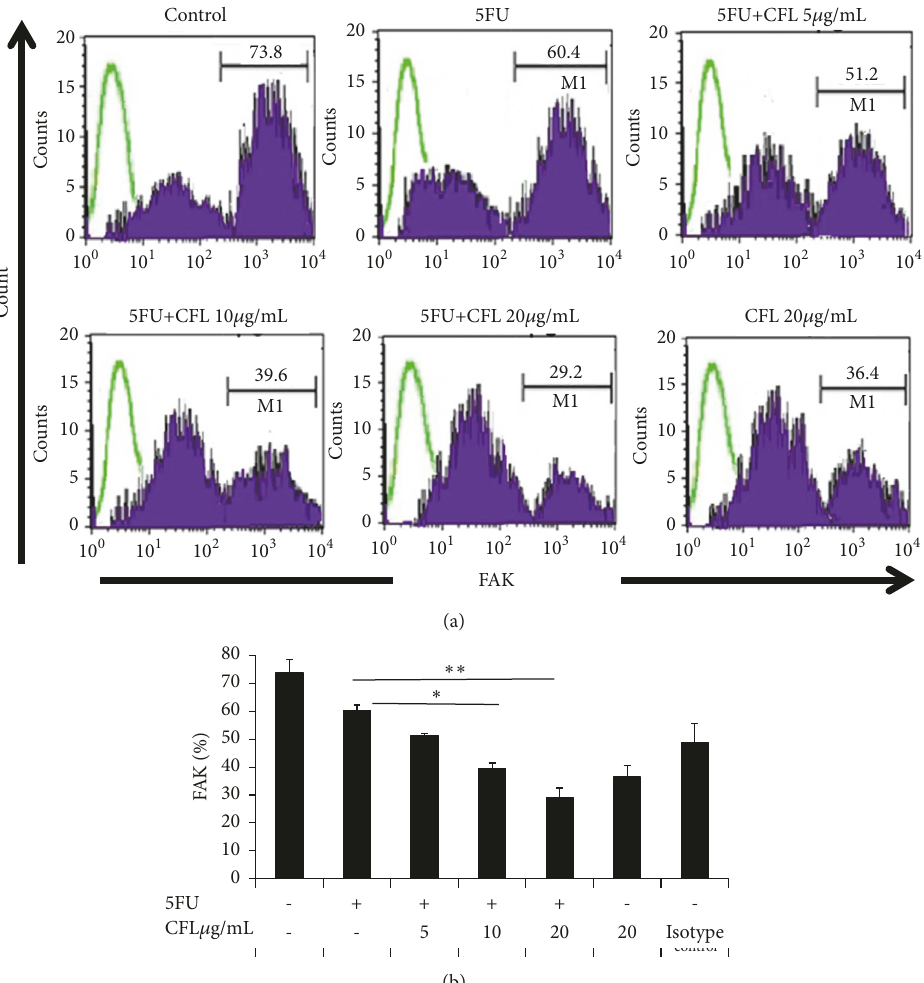
Figure 2: The combination therapy of CFL with 5-fluorouracil reduced the percentage of FAK protein level in HT-29 cells . HT-29 cells were cultured and divided into six groups: group 1 was without treatment (control); group 2 was treated with 5-fluorouracil (5FU), groups 3-5 were treated with either CFL 5, 10, or 20 𝜇 g/ml added immediately after 5-fluorouracil,and group 6 was treated with CFL 20 𝜇 g/ml. The percentage of FAK of 5FU group was significantly different from the three groups of 10 𝜇 g/mL (p < 0.05) and 20 𝜇 g/mL (p < 0.05) and CFL groups (p < 0.05). (a) Results are representative of four independent experiments. Green lines show isotype control IgG2b. (b) Number of FAK positive cells. Results shown are mean ± SD, with n =4 replicates in each group. ∗ p < 0.05, ∗∗ p <